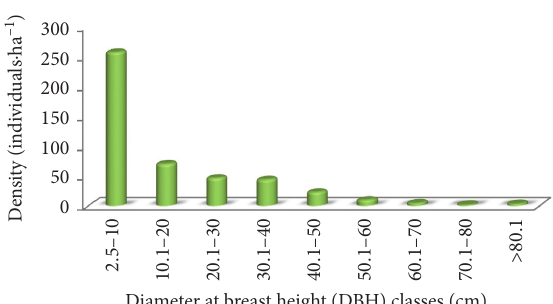
Figure 7: Diameter class distribution of woody species in Kafta Sheraro National Park.